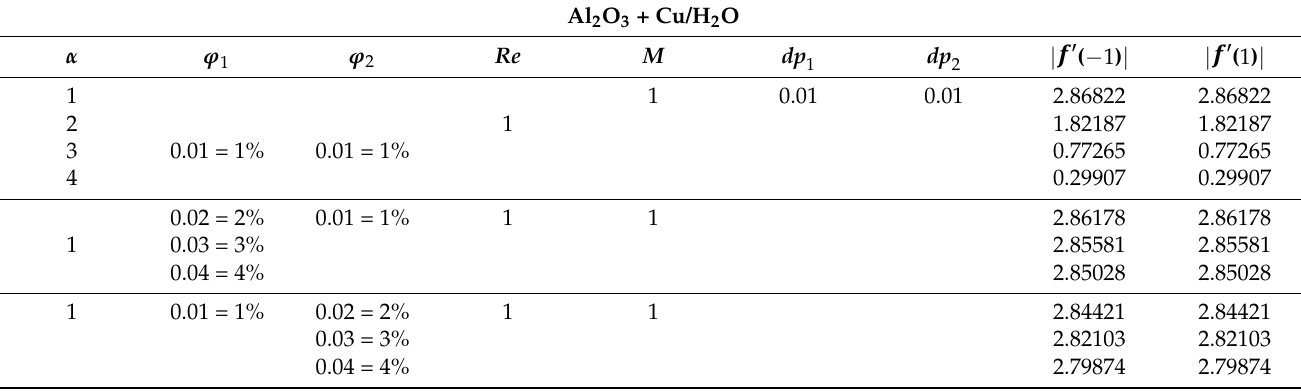
Table 4. Calculations of the effect of shear stress at the lower and upper disks for Al 2 O 3 + Cu/H 2 O HN fd for different nondimensional parameters.